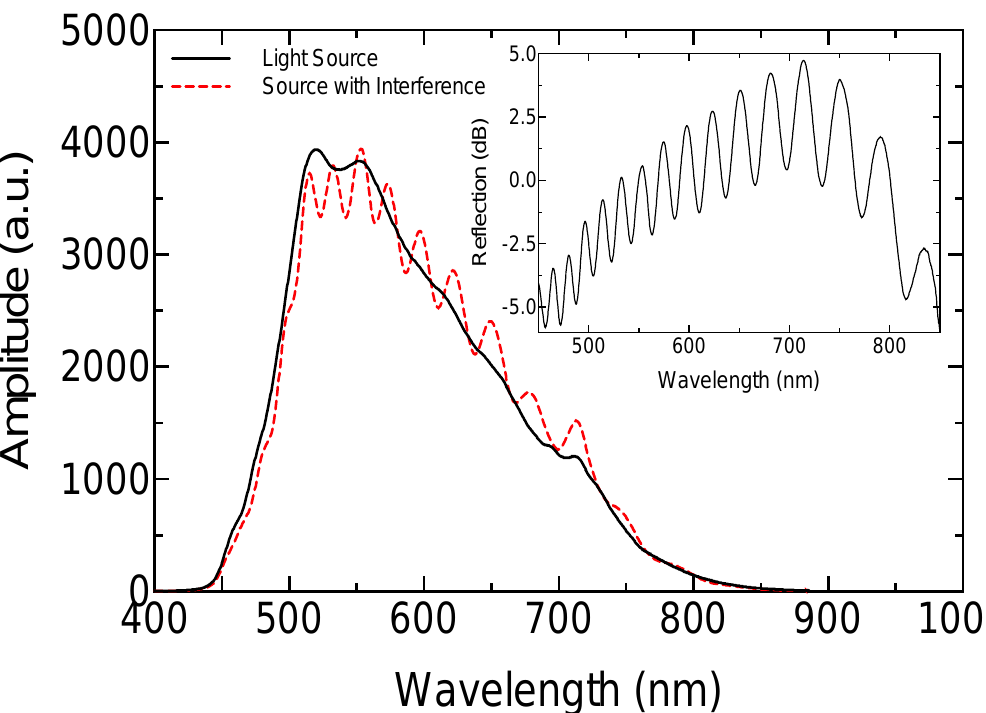
Figure 5. Reflected spectrum of the light source and optical interference response. Inset is the reflection signal.